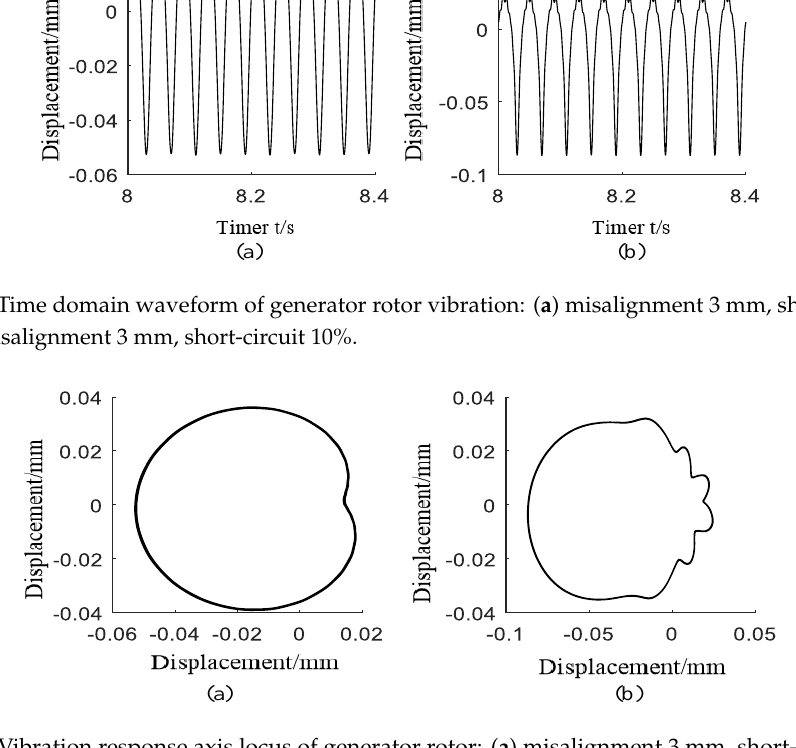
Figure 9. Vibration response axis locus of generator rotor: ( a ) misalignment 3 mm, short-circuit 1%; ( b ) misalignment 3 mm, short-circuit 10%.